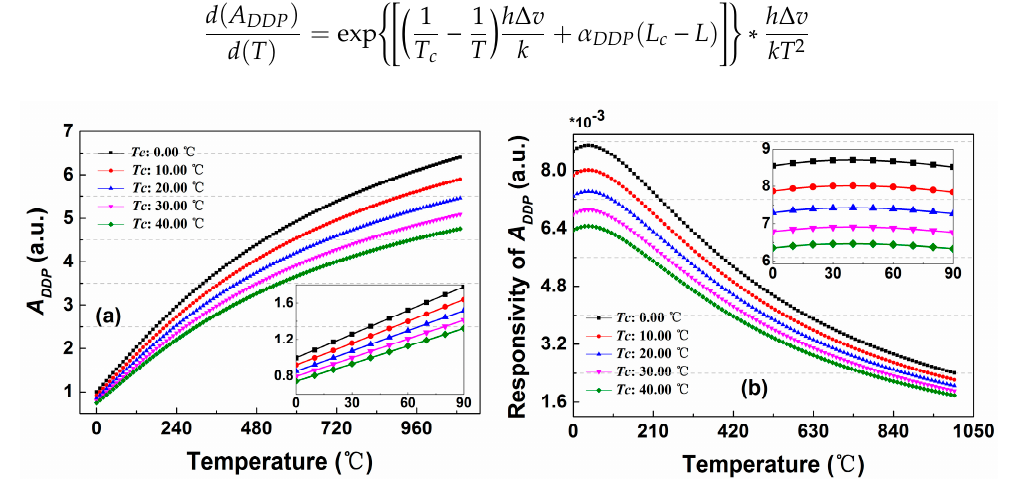
Figure 14. ( a ) The relationship of A DDP and the measurement temperature under the different calibration temperatures. ( b ) The responsivity of A DDP to the measurement temperature. temperatures. ( b ) The responsivity of A DDP to the measurement temperature.